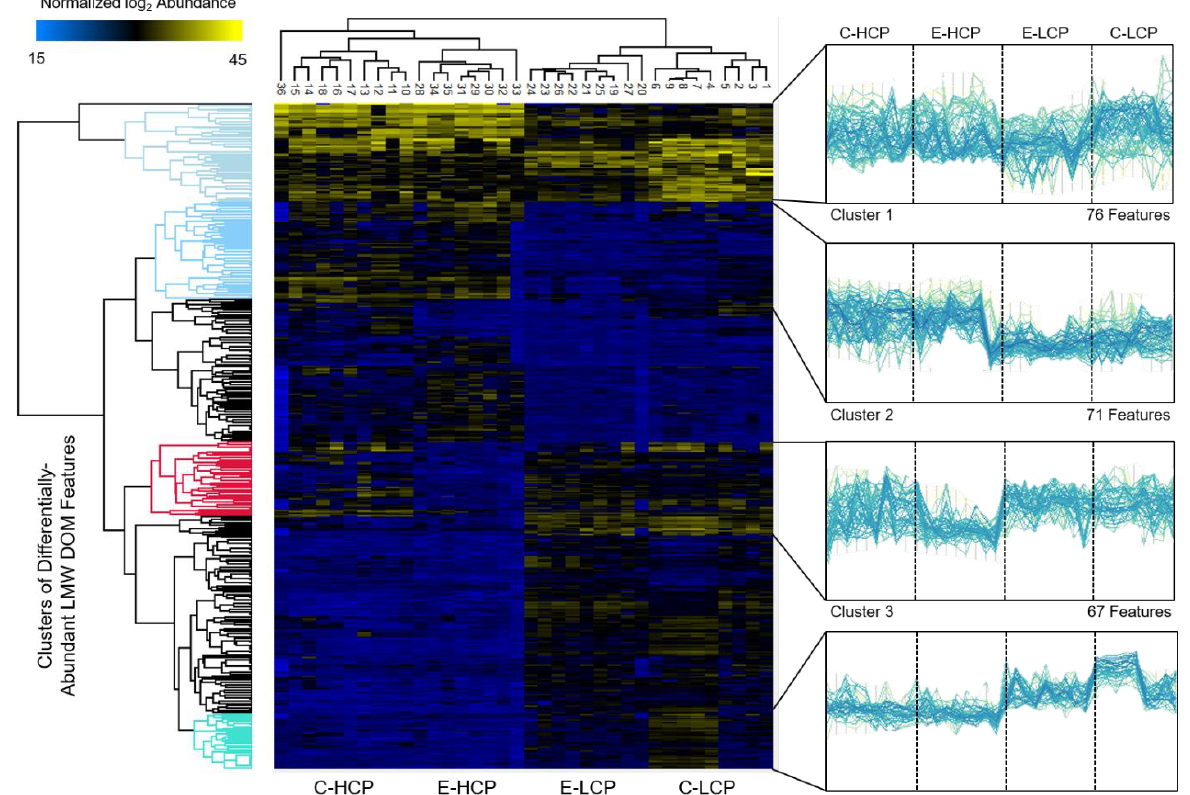
Figure 6. Heat map of normalized log 2 abundances for differentially abundant LMW DOM features with 4 clusters called out for further analysis.